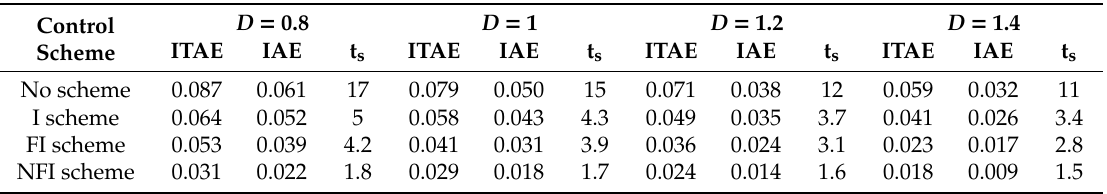
Table 4. Microgrid frequency indicators for different load types at test 1.